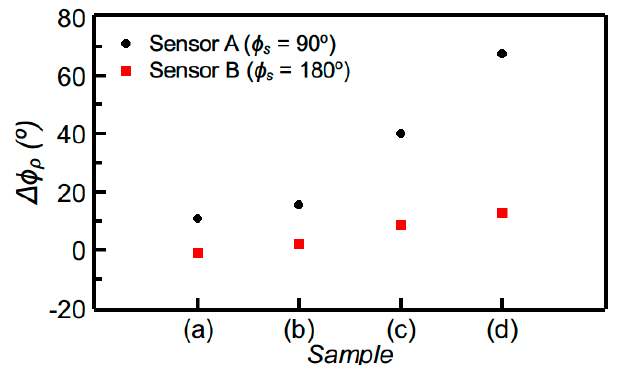
Figure 7. Differential phase of the reflection coefficient measured by covering the sensing line of sensors A and B with the samples of Figure 6.